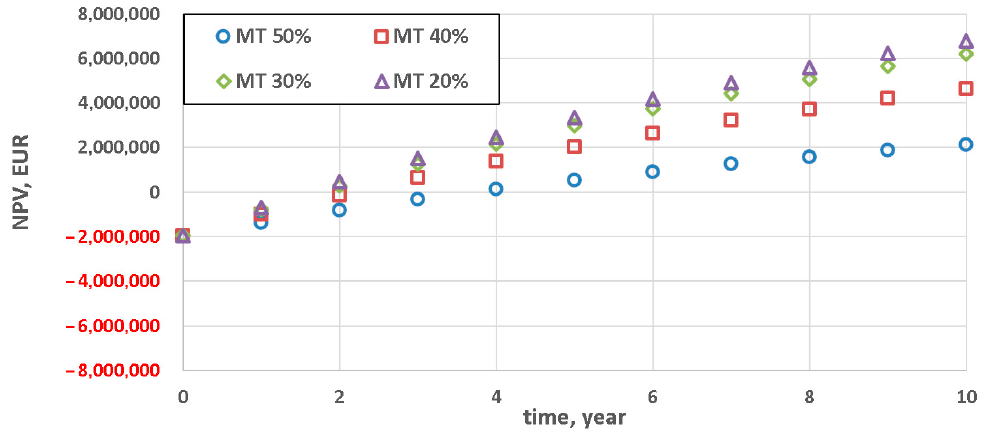
Figure 3. Results of Net Present Value analysis for different variants of achievable power unit technical minimum (MT) at coefficient Y = 0 (identical power of plasma torches assumed for all technical minimum levels).